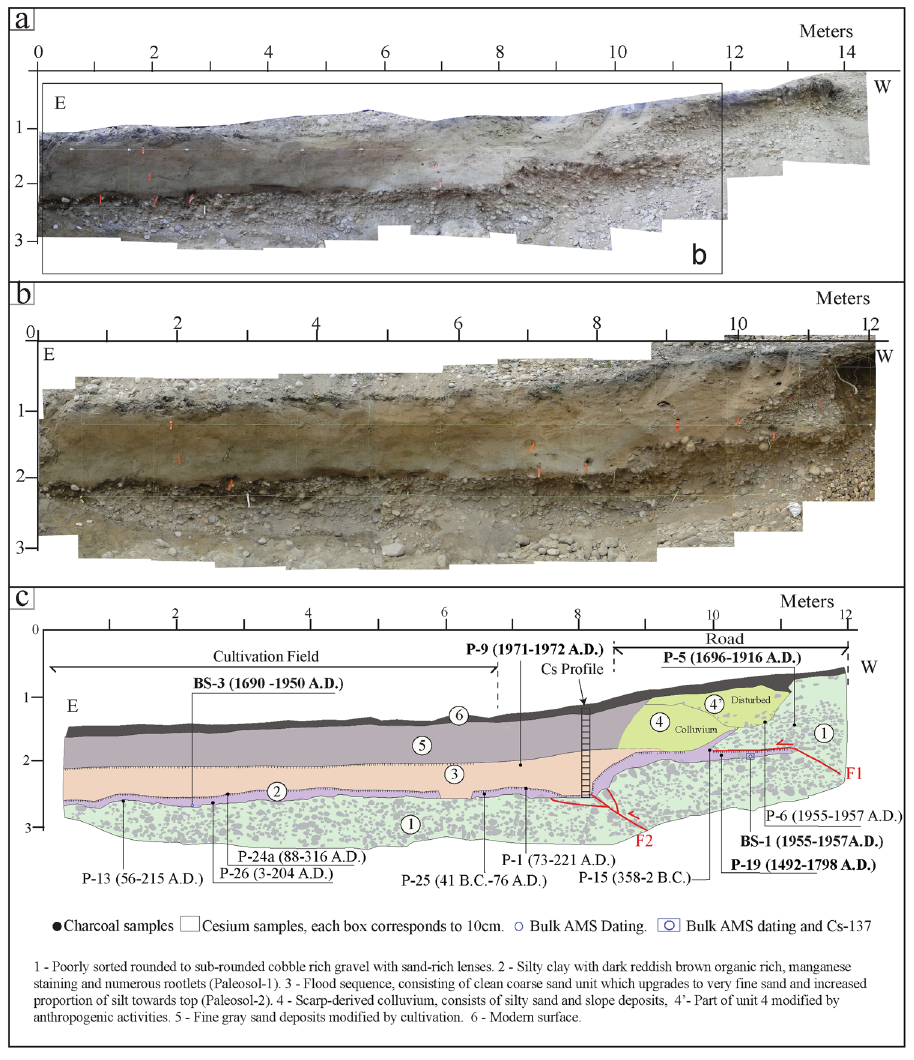
Figure 3. ( a ) Photomosaic of the excavated trench exposure at Pasighat. ( b ) Photomosaic of the trench exposure shown in Fig. 3c. ( c ) Illustrative log of the trench exposure shown in Fig. 3b showing different stratigraphic units in relation to the faulting event and the sample locations. Magnified image of the faulted portion of the trench exposure is provided in the Supplementary Fig. S1d. Mosaic of the trench photographs was done in Adobe Photoshop CS5 software and artwork in Adobe Illustrator